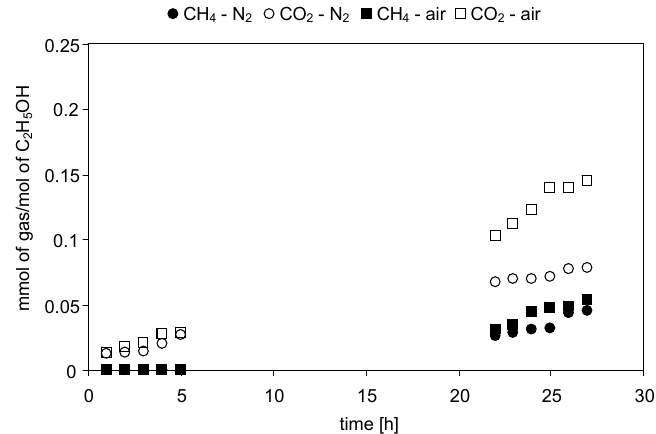
Figure 3. Evolution of CH 4 and CO 2 in time of irradiation during the photocatalytic degradation of C 2 H 5 OH. Photocatalyst loading: 1g/dm 3 ; C 2 H 5 OH concentration: 1 mol/dm 3 ; solution pH: 4.8; t = 25 °C.